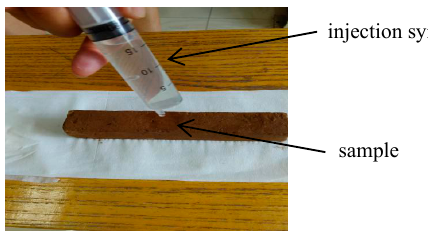
Figure 7. Water film transfer.